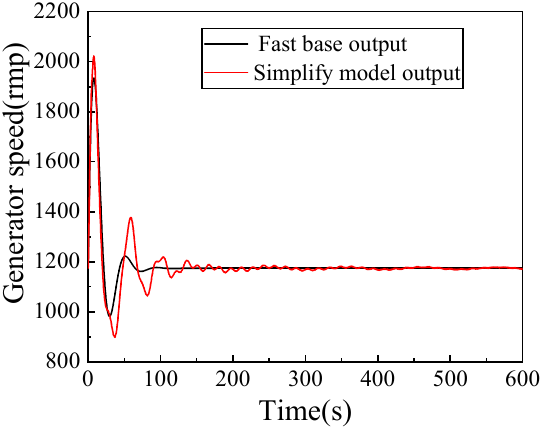
Figure 1. Comparison of generator speed between the base output of FAST and the output of the simplified model.